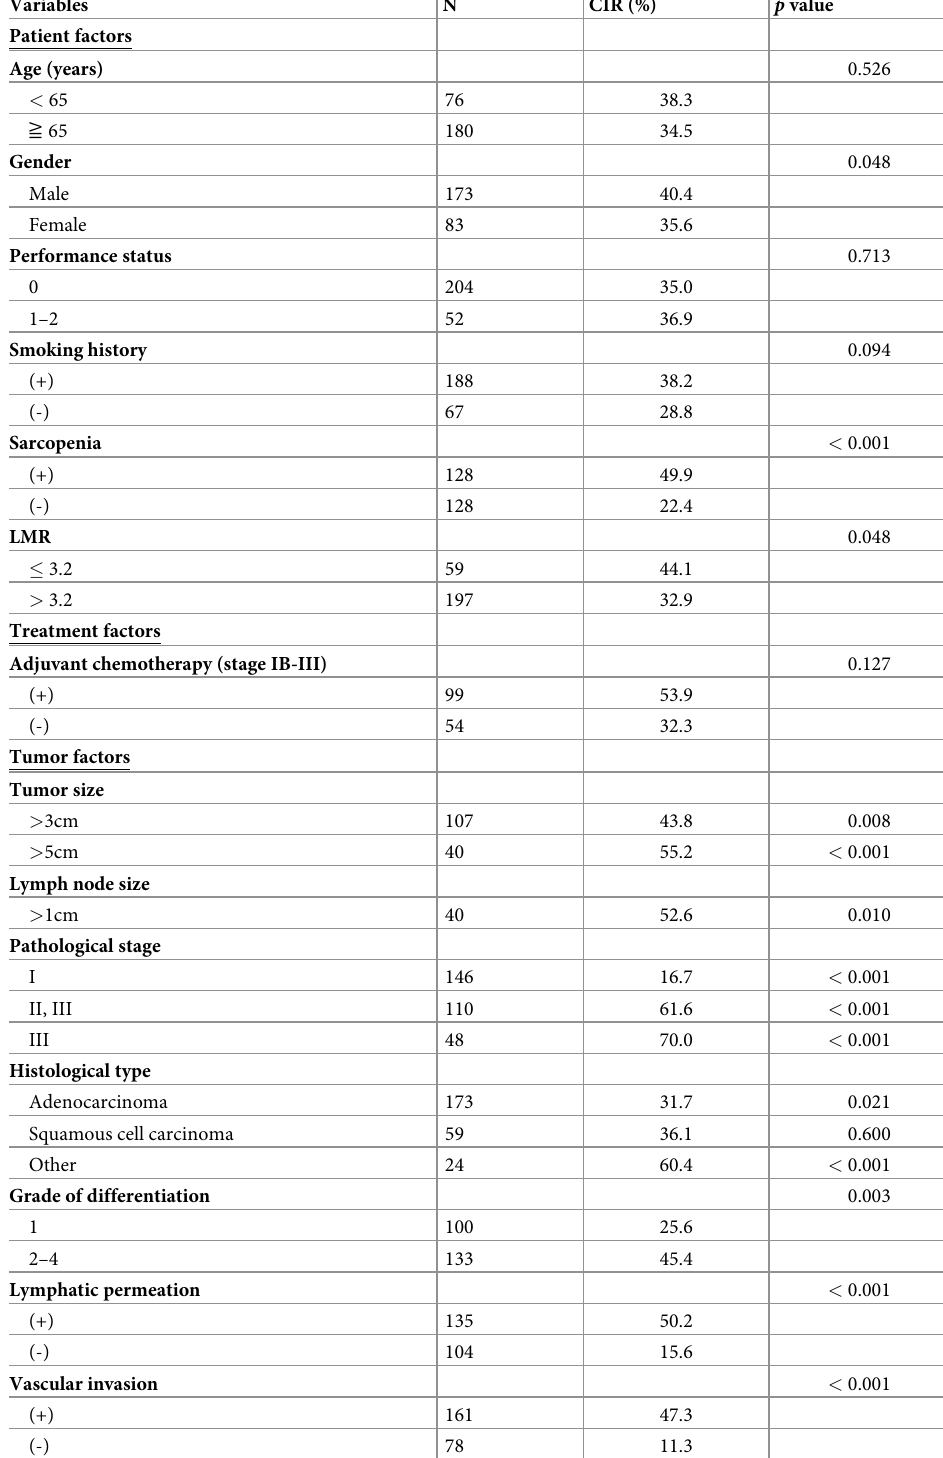
Table 2. Association between CIR rate and clinicopathological